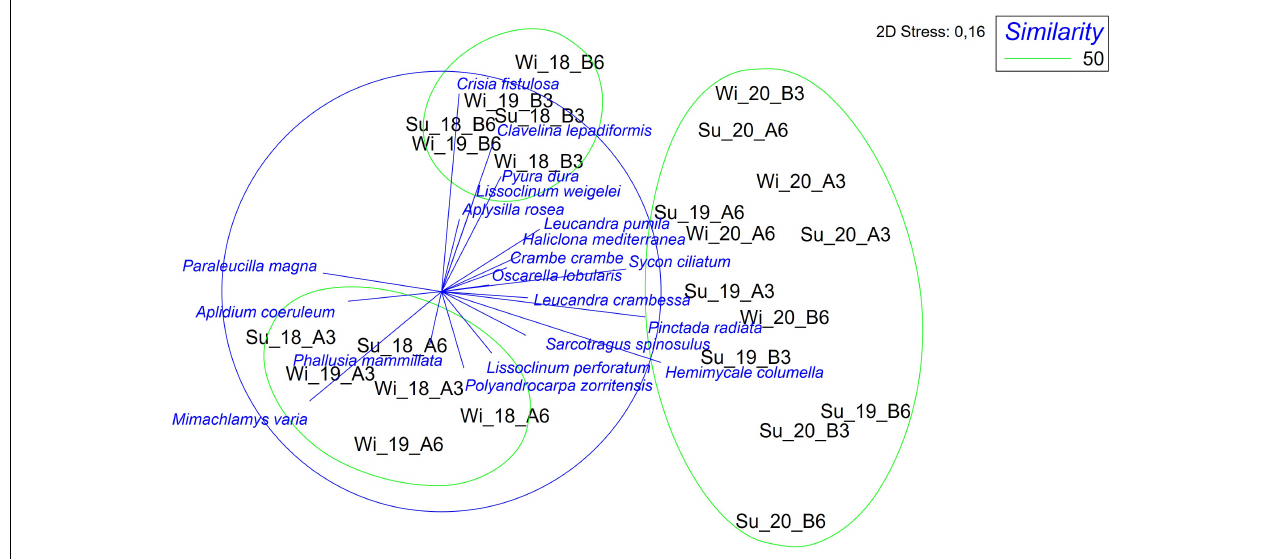
FIGURE 5 | Non-metric multidimensional scaling (nMDS) plots showing the hard substrate with species characterizing the different sampling periods as overlay vectors. Wi = winter; Su = summer.